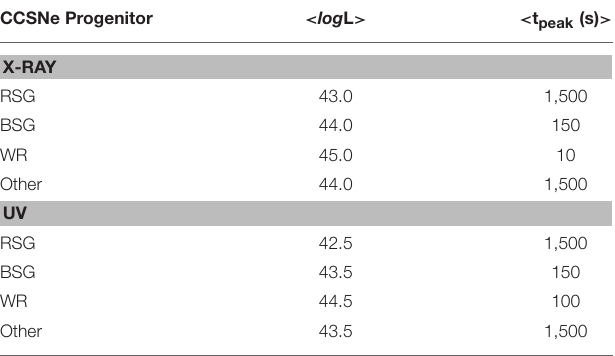
TABLE 5 | Simulation properties. CCSNe